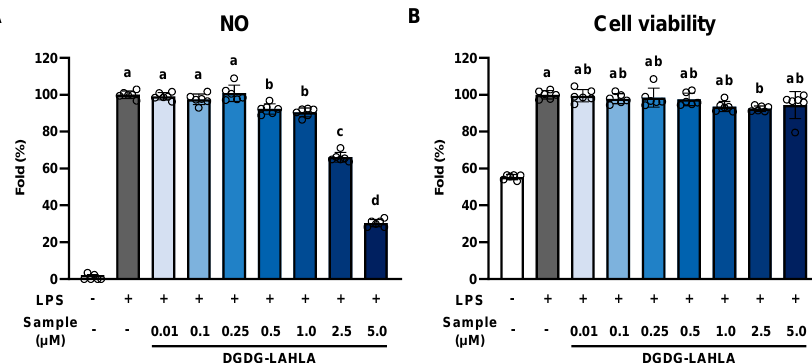
Figure 4. Effect of DGDG-LAHLA towards ( A ) NO production and ( B ) cell viability. RAW264 cells treated with LPS (100 ng/mL) were co-treated with DGDG-LAHLA (0.01–5 µ M) and incubated for 24 h. NO in the culture supernatant was measured using Griess reagent. Cell viabilities were measured using WST-1 reagent. Data represents mean ± SD ( n = 6). Different letters indicate significant differences ( p < 0.05, Tukey’s test).